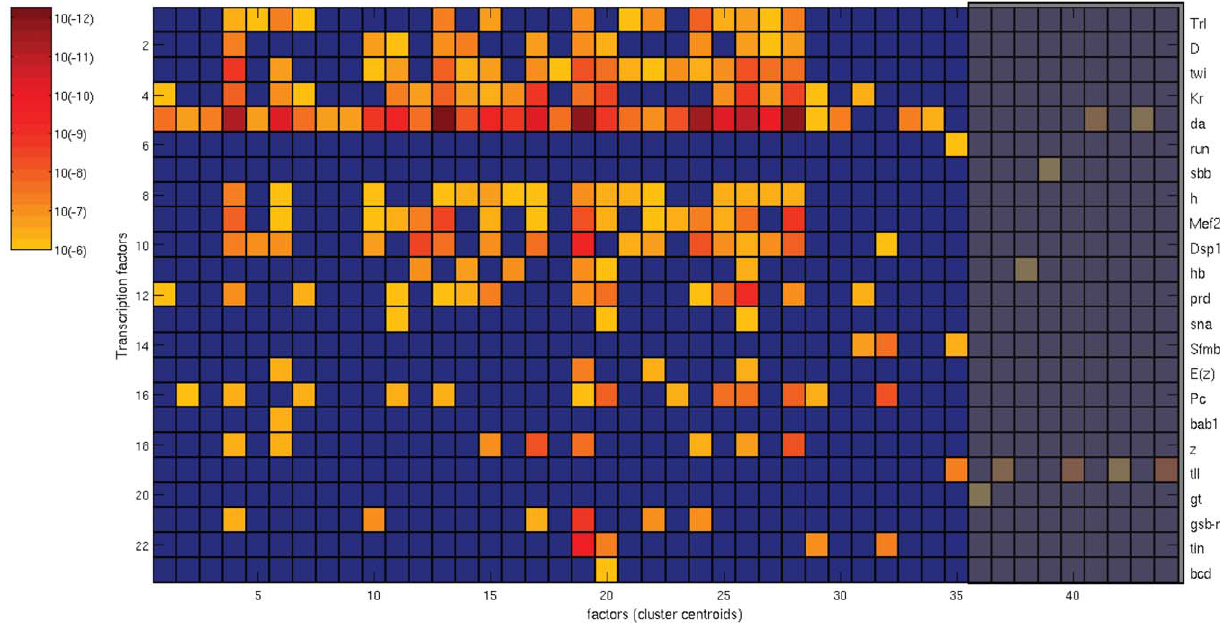
Figure 6. Significant transcription factors, for 44 representative factors (cluster centroids), developmental stages 11 – 12 . The level of significance of each TFs (vertical axis) is displayed as color intensity between yellow (p-value * 10 { 6 ) and red (p-value * 10 { 12 ), as indicated by the color bar on the left side; smaller p-values correspond to more significant genes. The blue color corresponds to TFs with a corrected p-value w 10 { 6 .